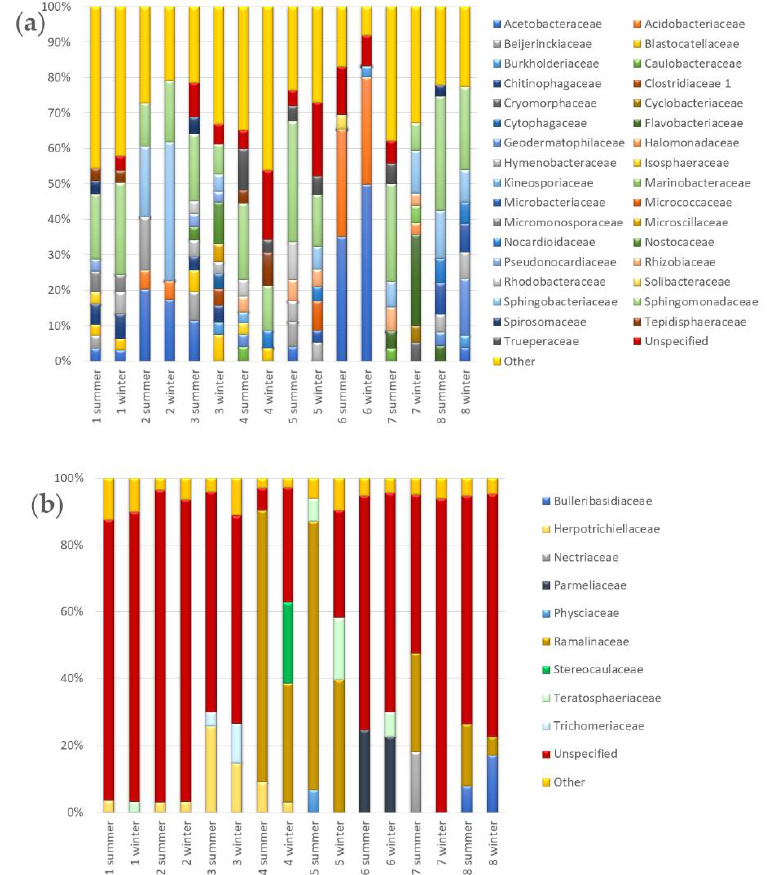
Figure 7. Seasonal biodiversity based on bacterial and fungal family composition. Two stacked-bar plots show percentage composition of bacterial ( a ) and fungal ( b ) families identified across samples in summer and winter. Taxonomy was assigned using Naive Bayes classifier (QIIME 2 package) with Silva 132 database and UNITE v7.2 reference datasets. The total number of 33 bacterial and 9 fungal families constituted more than 3% in overall compositions. Two additional and artificial groups were created to include the families with abundance lower than the threshold ( Other below 3%) and the ones with unspecified (i.e., ‘ f __’) or uncertain (i.e., ‘ Incertae_sedis ’) taxonomic position assigned ( Unspecified ).